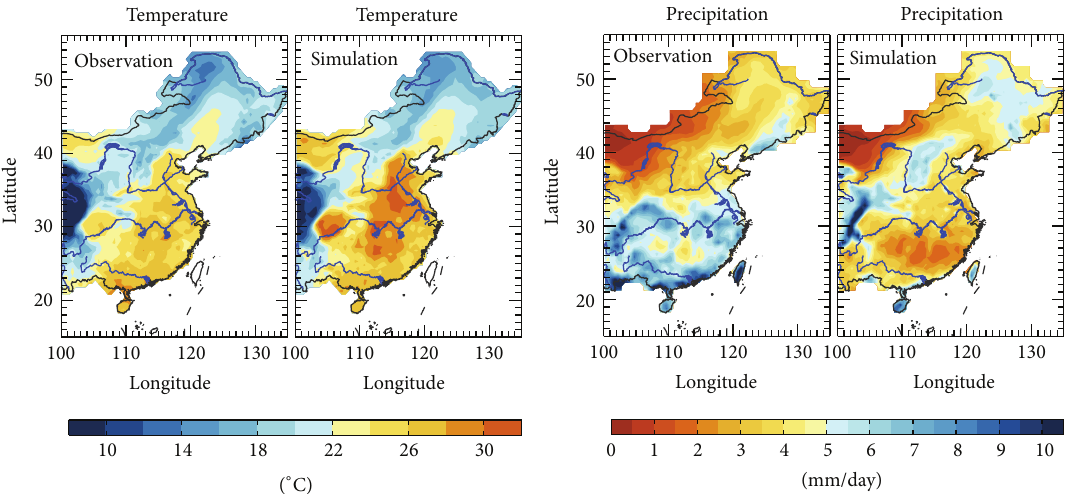
Figure 2: Ground observed and CTL simulated seasonal mean surface air temperature and precipitation for summer during the period